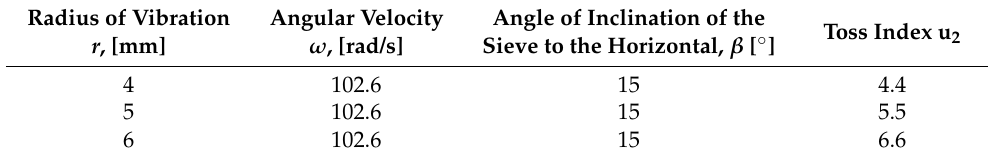
Table 9. Operating parameters of WSR